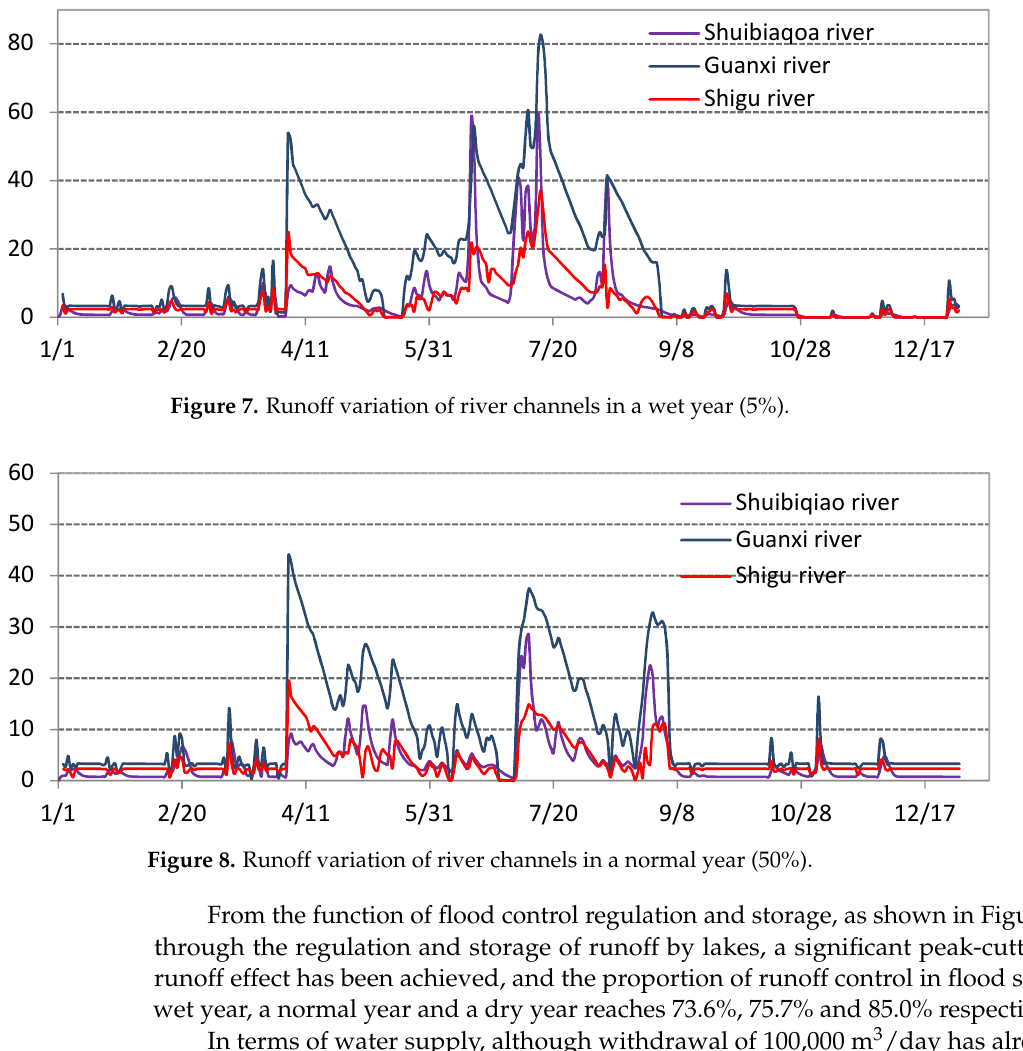
Figure 9. Runoff variation of river channels in a dry year (95%). From the function of flood control regulation and storage, as shown in Figures 10– 12, through the regulation and storage of runoff by lakes, a significant peak-cutting of the runoff effect has been achieved, and the proportion of runoff control in flood season in a wet year, a normal year and a dry year reaches 73.6%, 75.7% and 85.0% respectively.